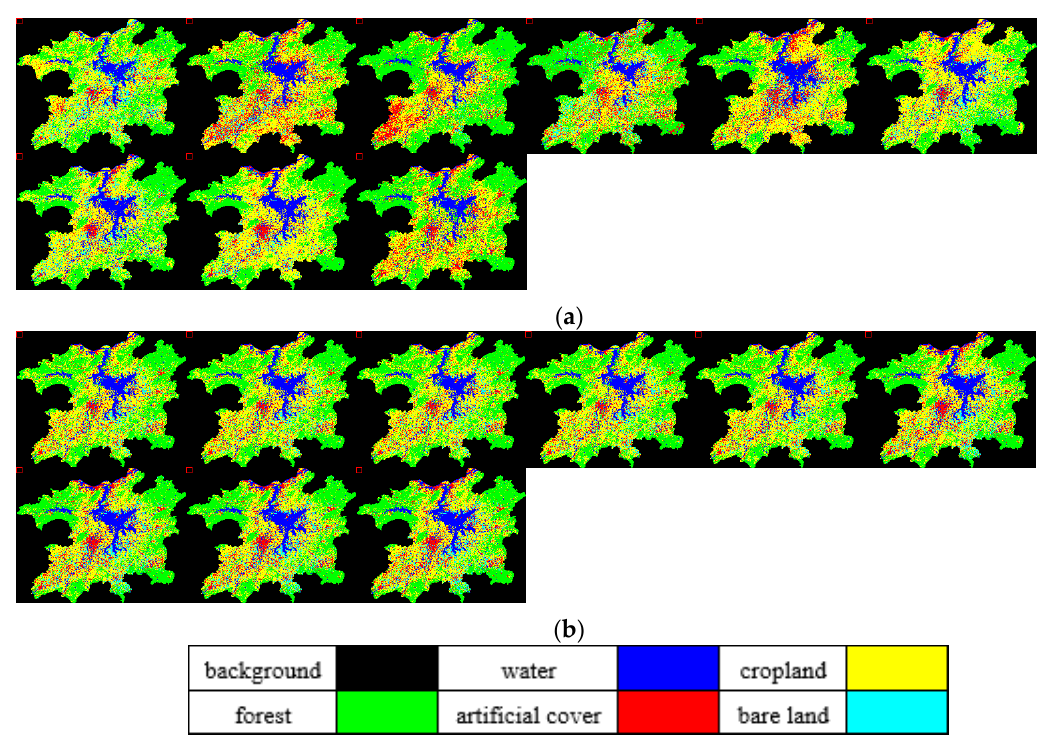
Figure 5. Classification maps of Poyang Lake Ecological Economic Region from 2007 to 2015. ( a ) Plan 1: NPP; ( b ) Plan 8: HMM1-1_spat.